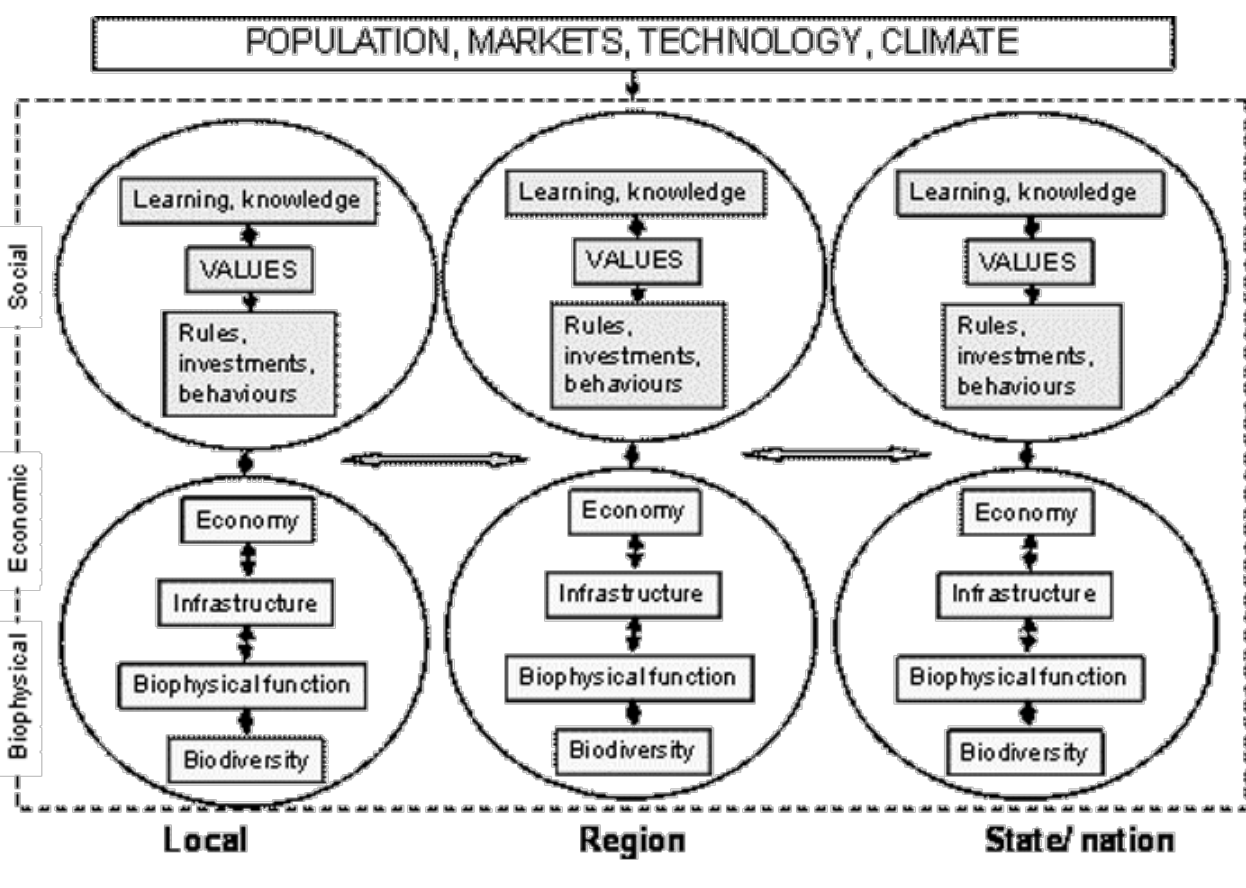
Fig. 2. Conceptual framework for regional change, showing categories of slow variables affecting the resilience of the